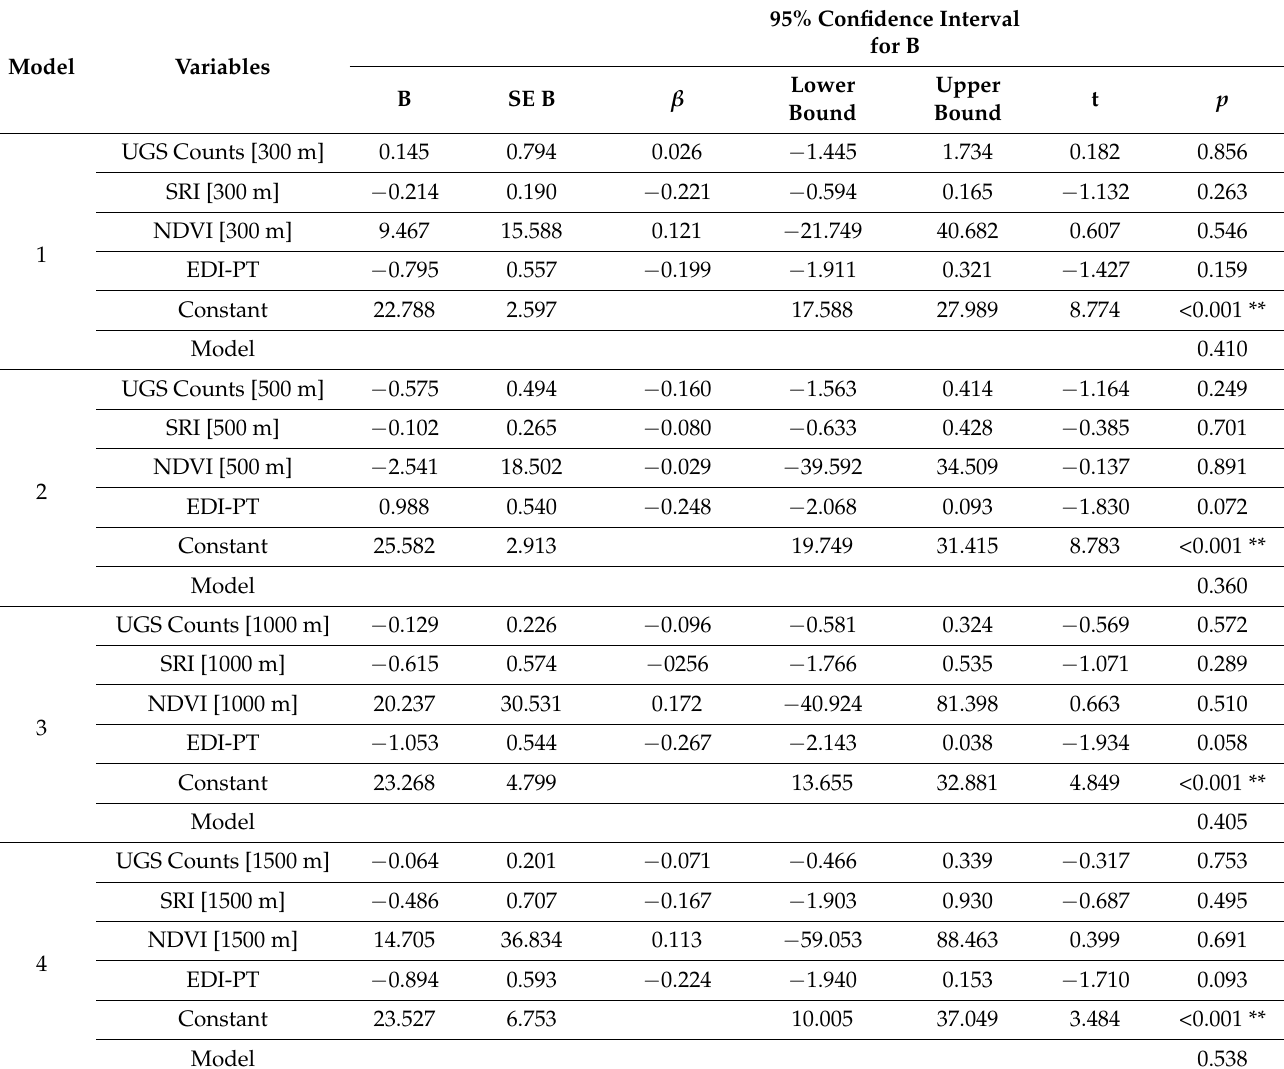
Table 4. The results of the multiple linear regression model for body mass index considering urban green space, normalized difference vegetation index and species richness index values with